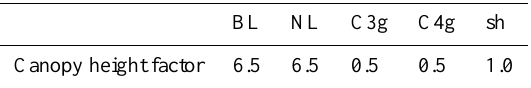
Table A2. Canopy height factor (metres) of JULES vegetation land cover types (PFTs) (BL: broadleaf tree, NL: needleleaf tree, C3g: C3 grass, C4g: C4 grass, sh: